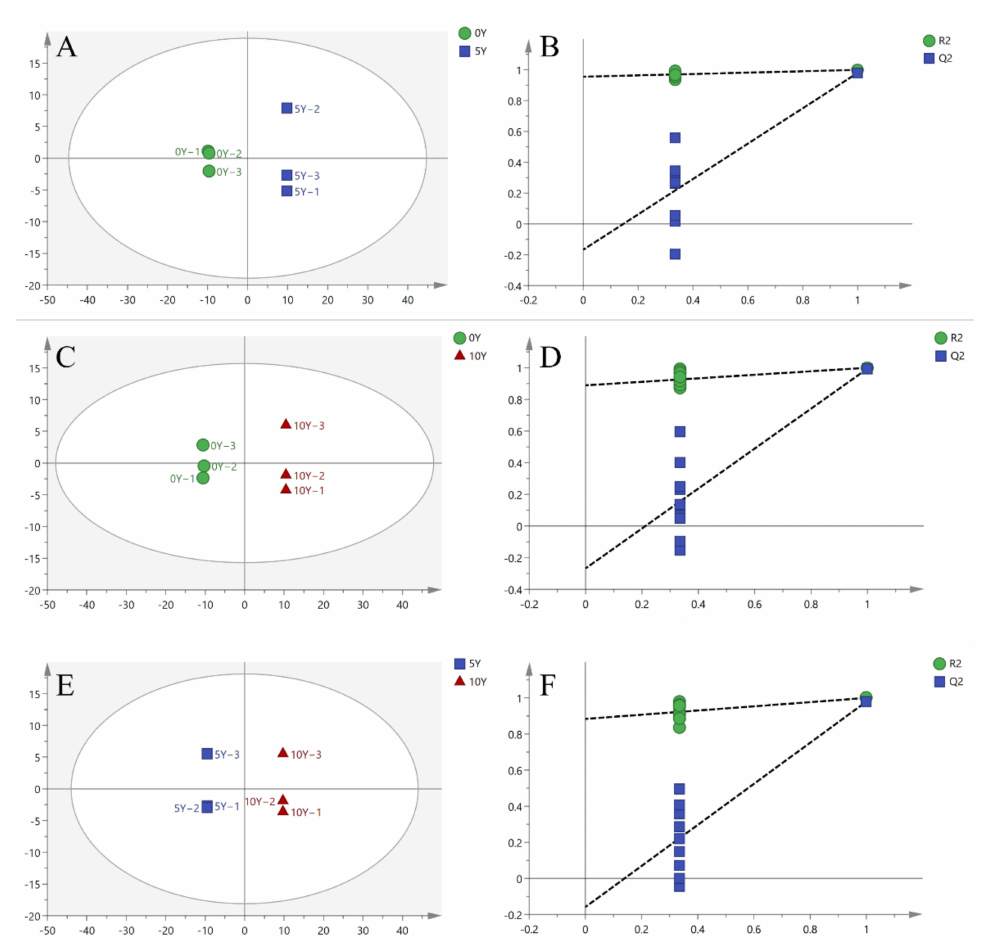
Figure 2. Scatter plots and permutation tests of the OPLS-DA models for fermented kohlrabi samples. ( A , C , E ) represent the OPLS-DA analyses for A1 (0Y–5Y), A2 (0Y–10Y), and A3 (5Y–10Y), while ( B , D , F ) represent permutation tests for A1 (0Y–5Y), A2 (0Y–10Y), and A3